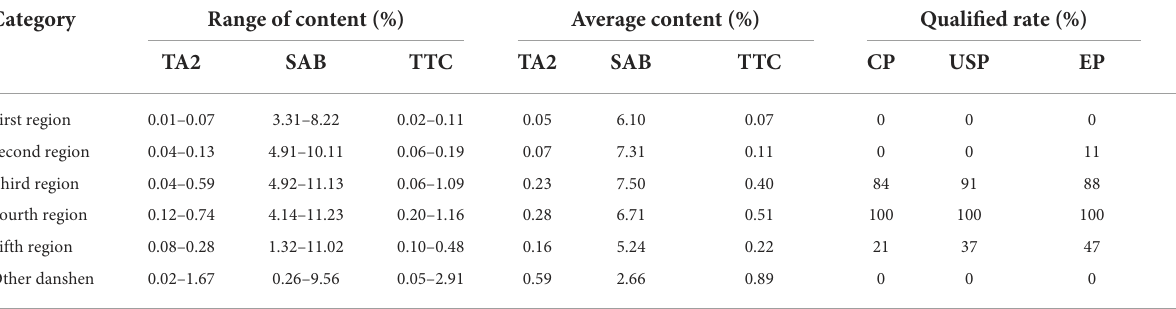
TABLE 3 The qualified rate of samples from different sources according to the current standards. Category Range of content (%) Average content (%) Qualified rate (%)